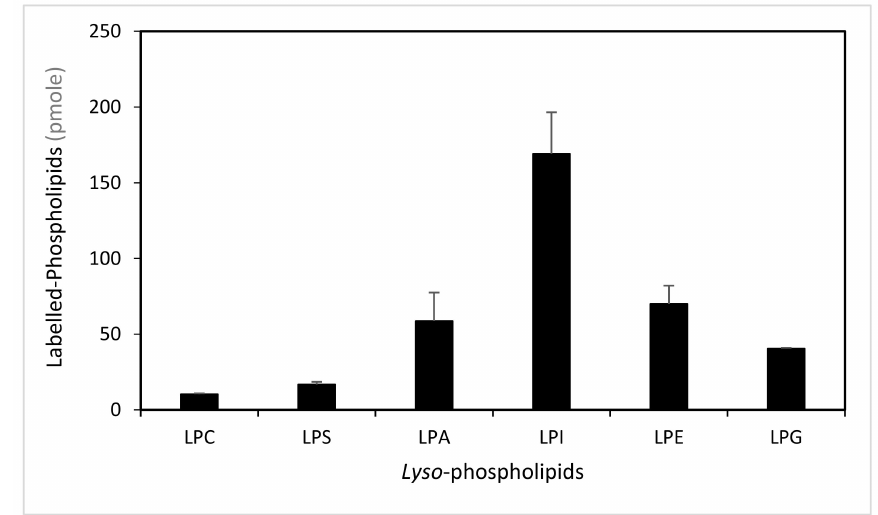
Figure 1. Determination of the lyso -phospholipid specificity. Labelled-phospholipids were synthesized by in vitro acylation of lyso -phospholipids, catalysed with membranes from E. coli transformed by pET-15b:: LPIAT plasmid (100 µ g protein / assay) corrected by the amount of labelled phospholipids obtained with membranes transformed by empty pET15b. Assays were carried out with 3 nmol of [ 14 C]-C18:1-CoA and 2 nmol of lyso -phospholipids. After 60min incubation, lipids were extracted and analysed by thin-layer chromatography (TLC) followed by radioimaging. Values represent mean ± SD of three biological replicates. LPC, lyso -phosphatidylcholine; LPS, lyso -phosphatidylserine; LPA, lyso -phosphatidic acid; LPI, lyso -phosphatidylinositol; LPE, lyso -phosphatidylethanolamine; LPG, lyso